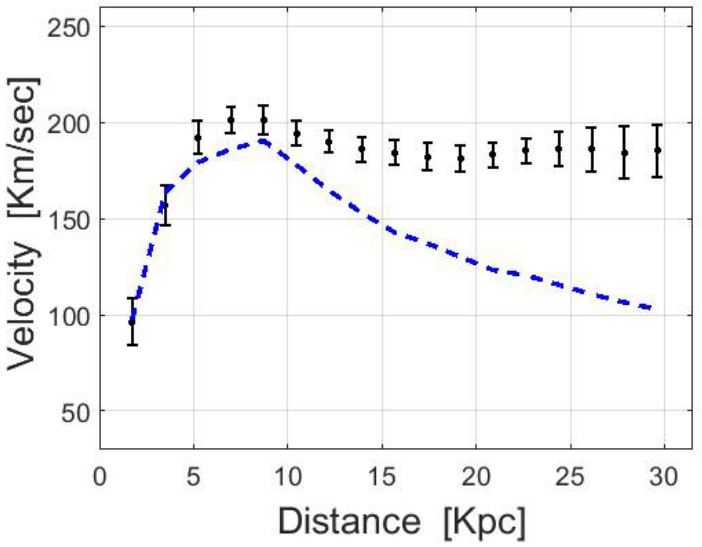
Figure 1. A measured rotation curve (black points with error-bars) and its Newtonian prediction (dashed blue line). The predicted curve is based on visible matter alone. The inconsistency with the observed data is known as the discrepancy in galaxy rotation curves. The data (NGC 4157) was taken from McGaugh’s Data Pages